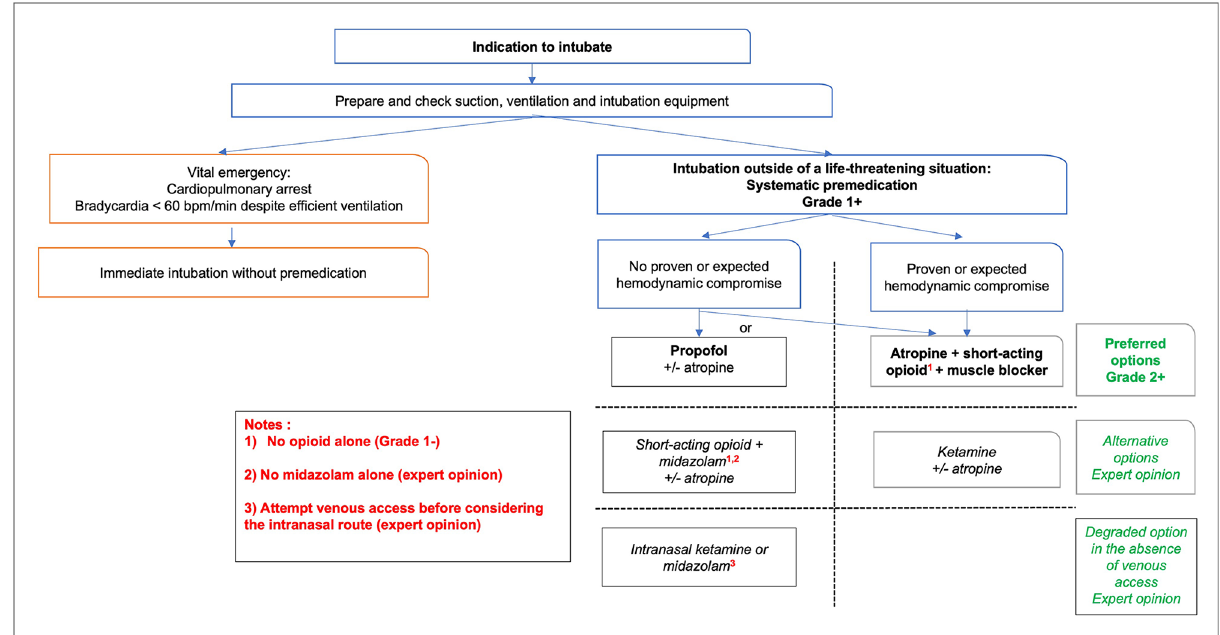
FIGURE 2 Decision chart for premedication before tracheal intubation in